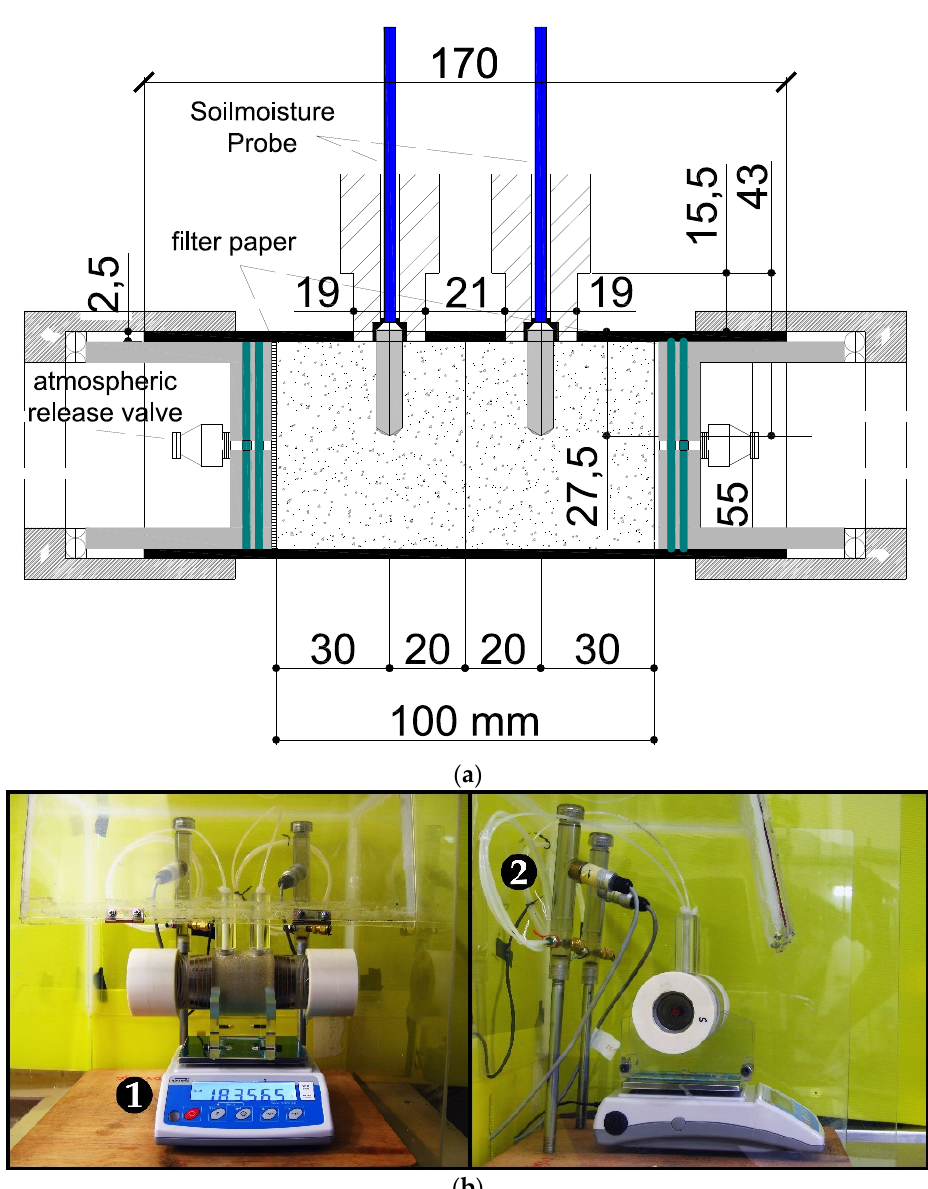
Figure 7. ( a ). Design of the experimental device for the investigation of hydraulic retention properties at element volume scale. ( b ). Actual working setup of the experimental device: (1) precision lab scale connected by RS232 to the data acquisition system for the continuous monitoring of the sample weight; (2) PT2 probe for temperature monitoring inside the isolation case.